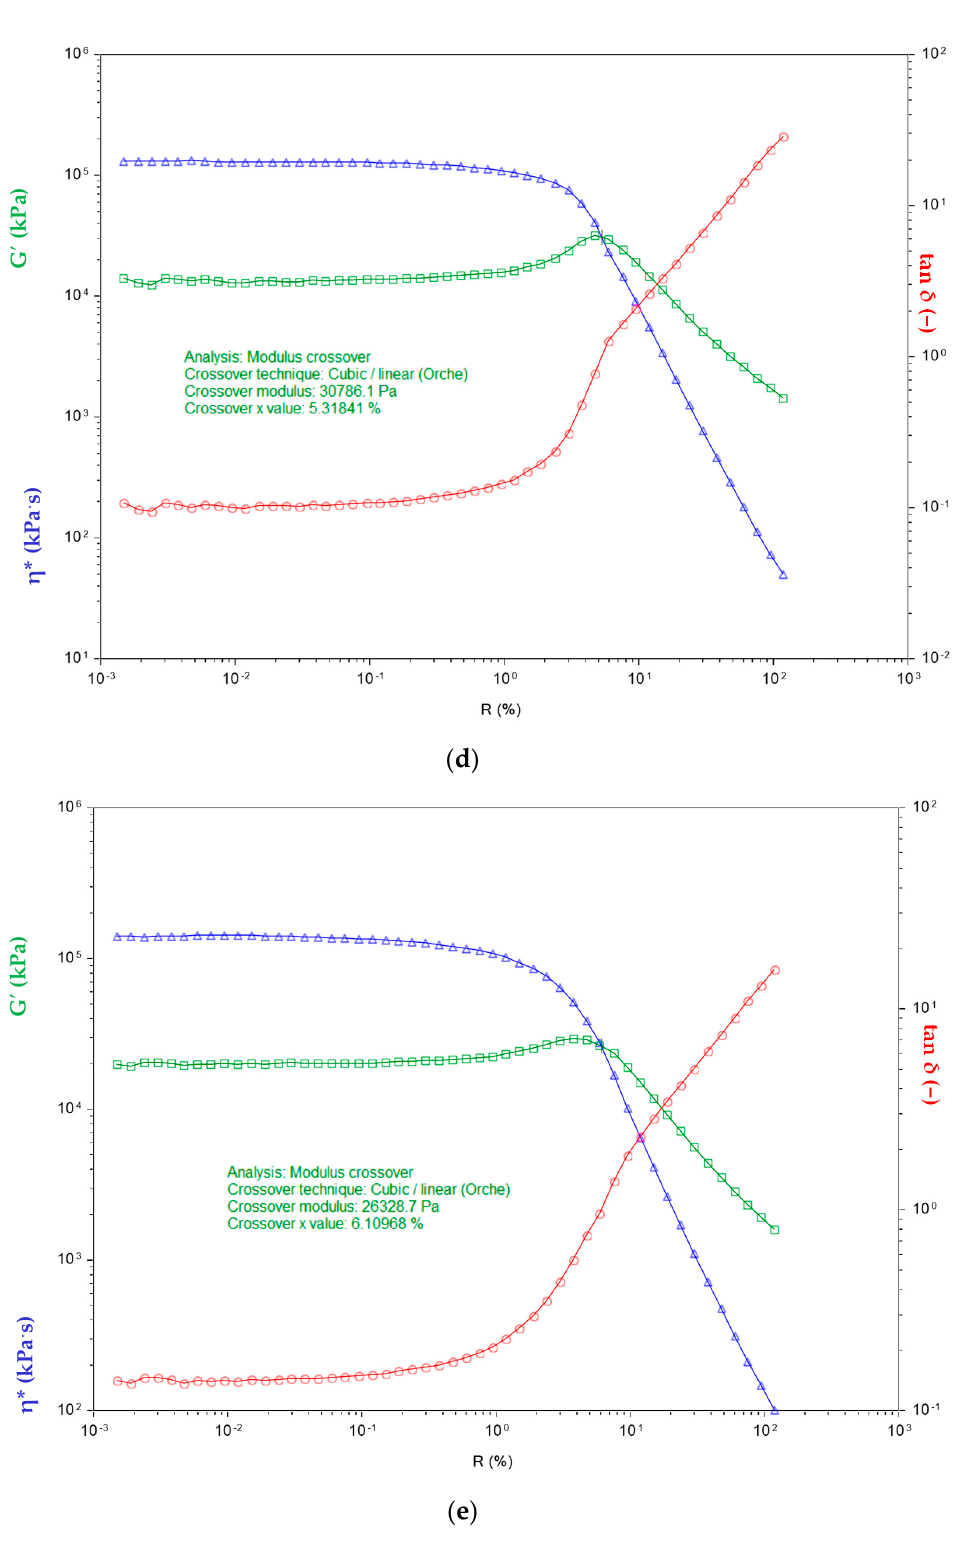
Figure 2. Dependence of viscosity and stress on the shear rate of the composites: ( a ) SBR; ( b ) SBR1 (10); ( c ) SBR2 (10); ( d ) SBR1 (20); ( e ) SBR2 (20). Sapphire curve —complex viscosity η * (kPa’s) at 80 ◦ C (processing temperature) for SBR mixtures; green curve—storage shear modulus G (cid:48) (kPa) of uncured rubber mixtures SBR at 80 ◦ C as a function of angular frequency ω (rad’s − 1) (linear viscoelastic region); red curve—mechanical loss tan δ ( − ) as a function of angular frequency ω (rad’s − 1) (oscillation strain